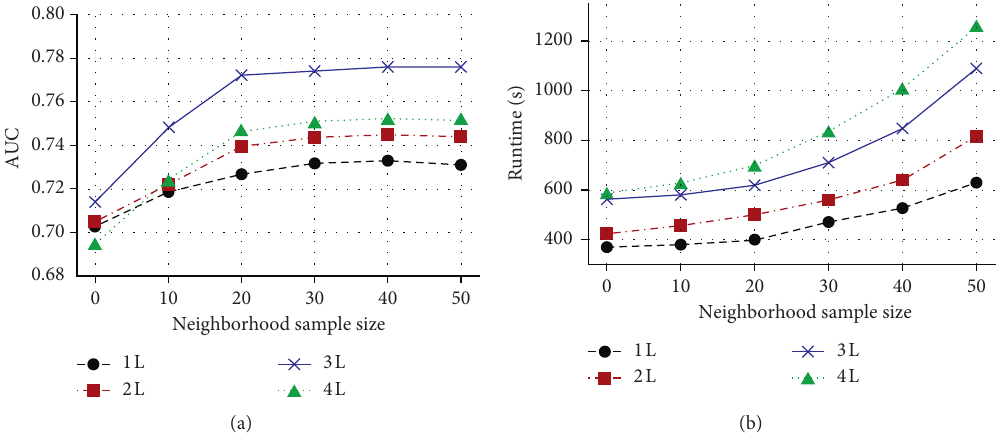
Figure 6: Performance evaluation of graph convolutional layers. (a) AUC. (b) Runtime.